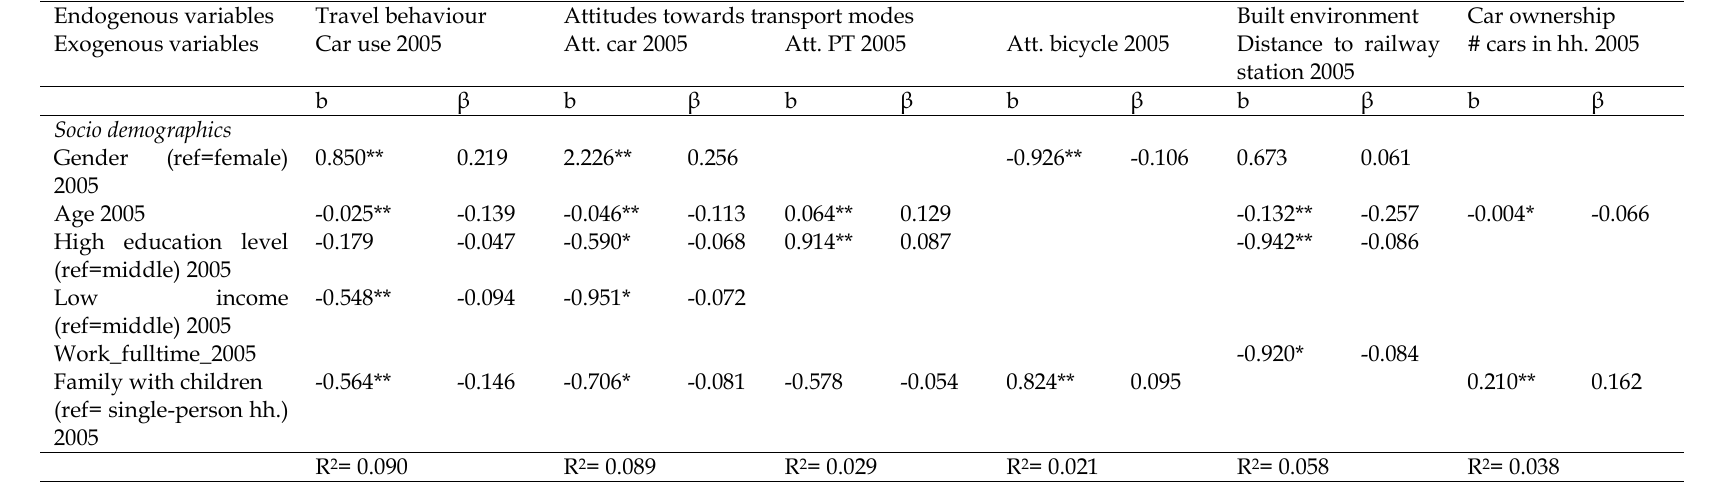
Table 3. Model 2 with car ownership and controls for socio-demographics